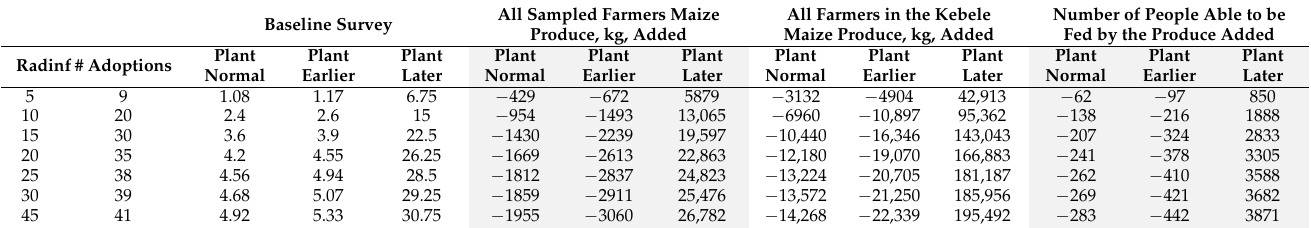
Table A6. Adoption rate of influence of radio, crop productivities of adopted numbers, and number of people able to be fed under less rain conditions.